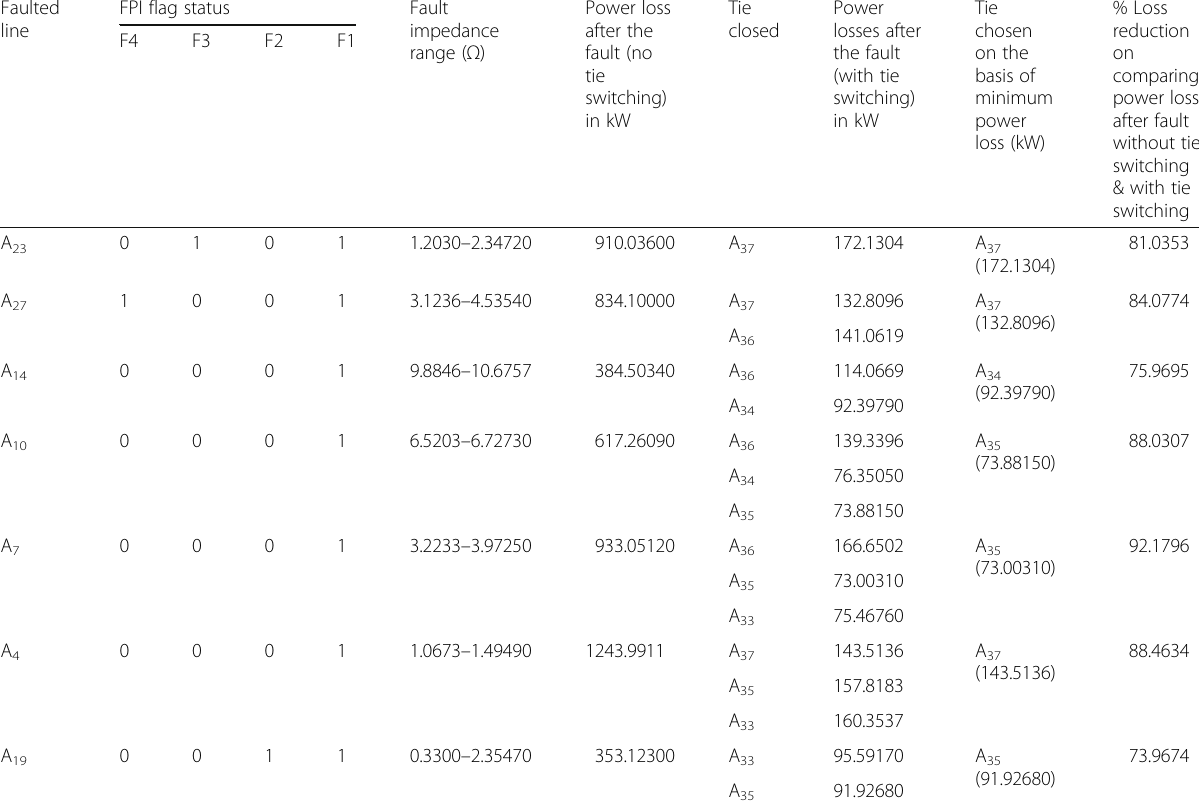
Table 5 Fault locations and tie switching in IEEE 33 bus distribution network Faulted FPI flag line